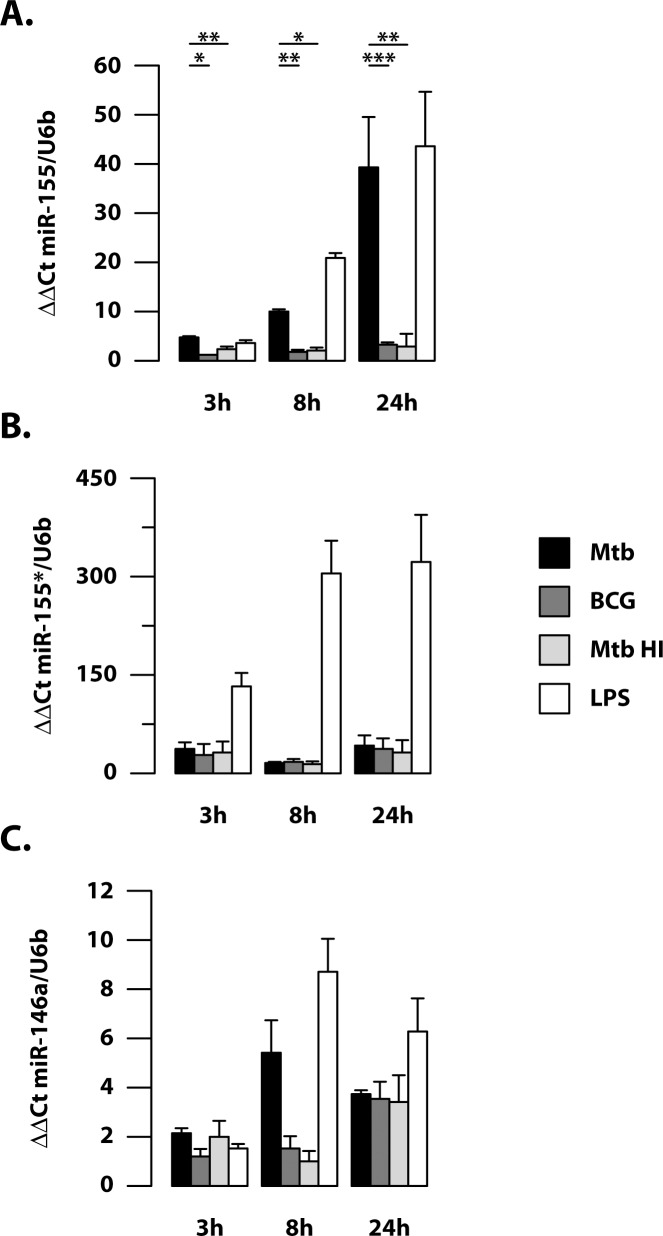
Modulation of miRNA expression in human DC infected with Mtb, BCG vaccine or treated with heat-inactivated Mtb and LPS.Relative expression of miR-155 (A), miR-155*(B) and miR-146a (C) in DC infected with Mtb or BCG vaccine or treated with heat-inactivated Mtb (Mtb HI) or LPS (1 μg/ml), as measured by q-PCR analysis. All quantification data are normalized to the U6b level using the equation 2-ΔΔCt. The results shown were mean fold change per sample ± standard error of the mean at 3, 8 and 24 hours post-infection of 3 healthy donors independently enrolled from those used in microarray study. (*p = 0.001; **p = 0.01; ***p = 0.02).